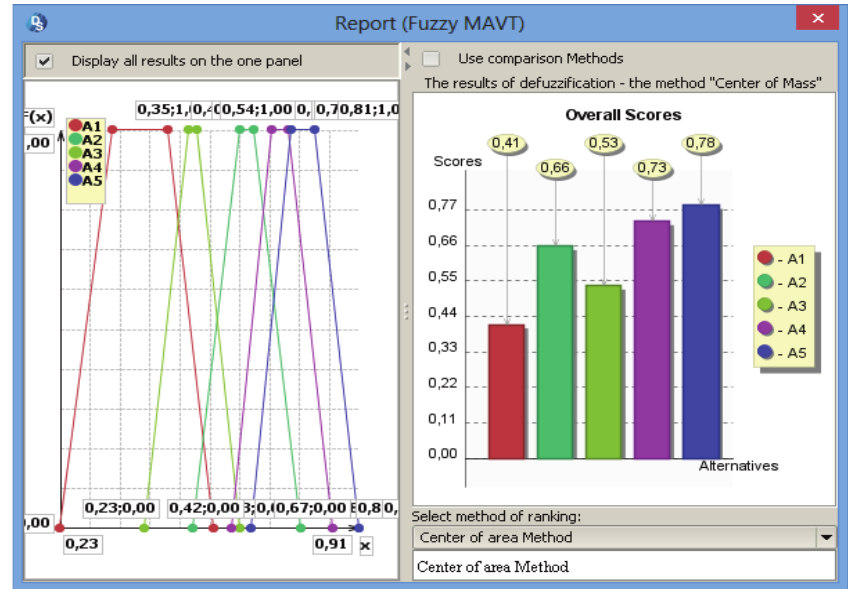
Fig.12. DecernsMCDA : analysis of alternatives with FMAVT.